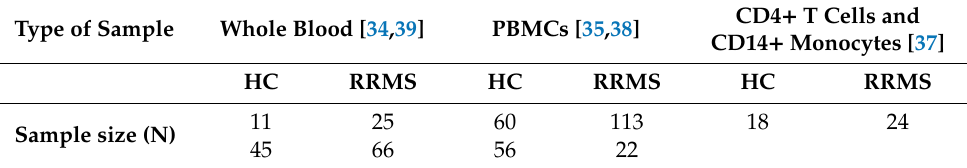
Table 1. Cohorts of subjects enrolled to evaluate the NURR1 gene expression